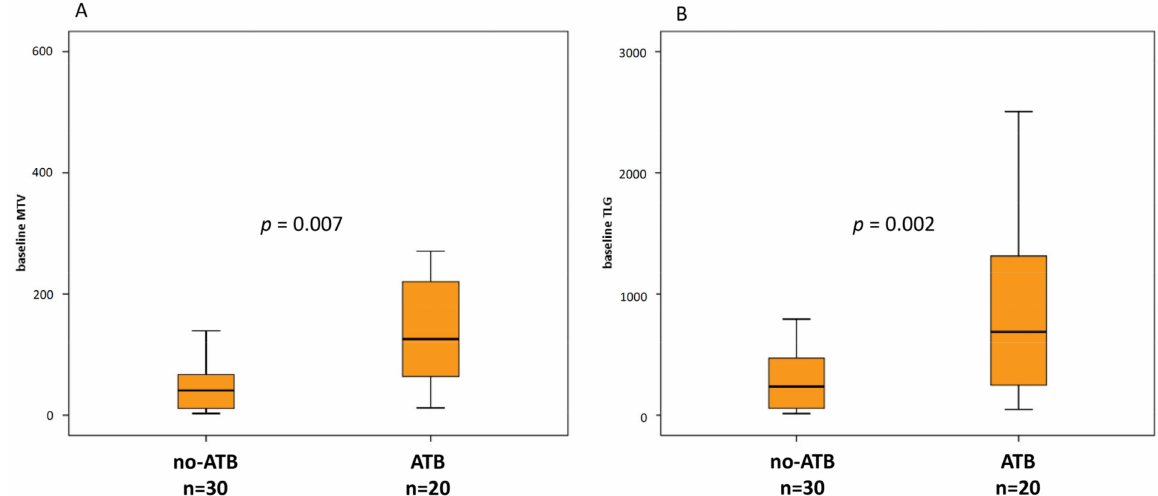
Figure 3. Box plots for metabolic tumor volume (MTV) ( A ) and total lesion glycolysis (TLG) ( B ) at baseline in patients without or with ATB 1 month before and/or 1 month after the first dose of ICI.